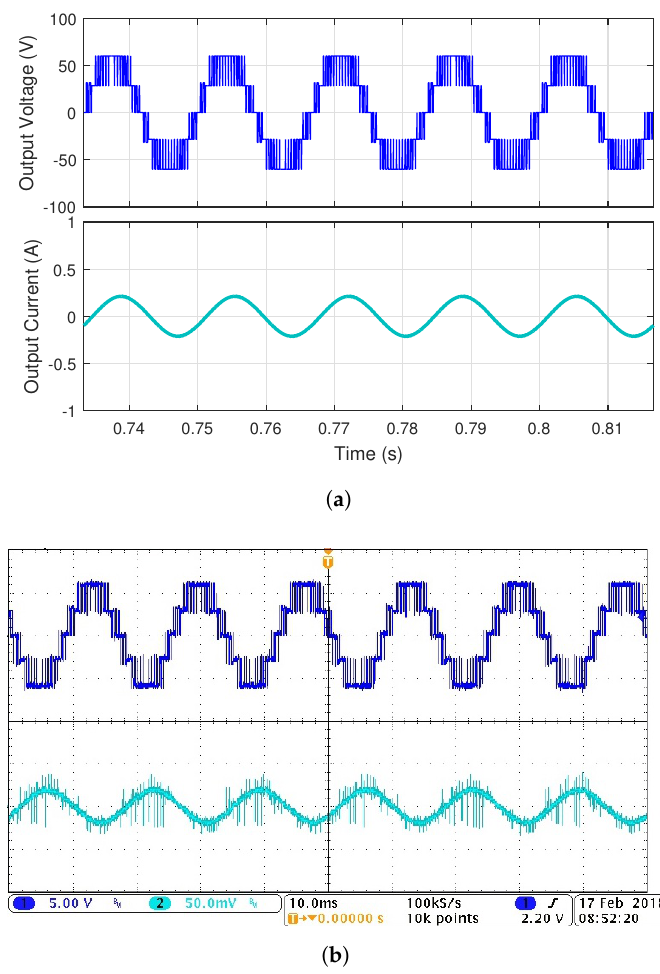
Figure 9. Results of five-level switched-source multilevel inverter (SS MLI): ( a ) simulated output voltage (top) and load current; ( b ) experimental output voltage (top, 25 V/div) and current (bottom, 0.25 A/div). Table 2. Parameters for 7-level and 31-level